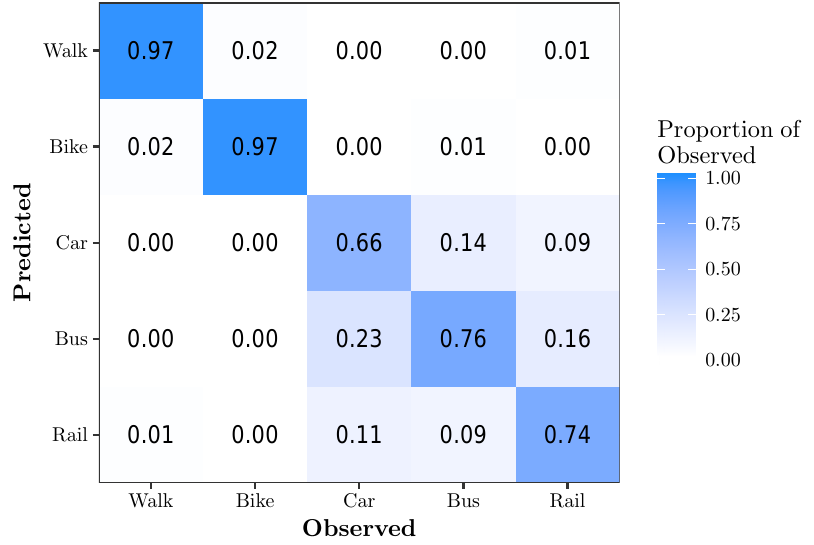
Figure 8. Confusion matrix for the optimal PCA-RF model, PCA-RF{3}. This model has an overall accuracy of 82.0% using 68.8% of the original feature